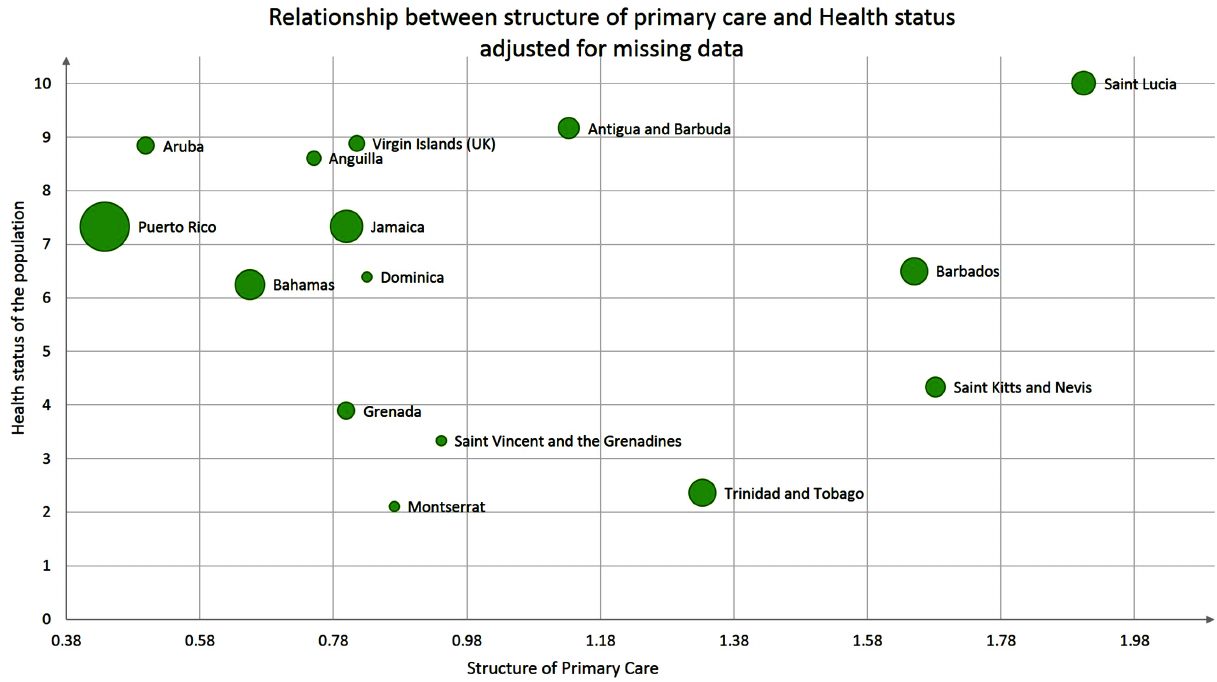
Figure 5 . Relationship between structure of PC and health